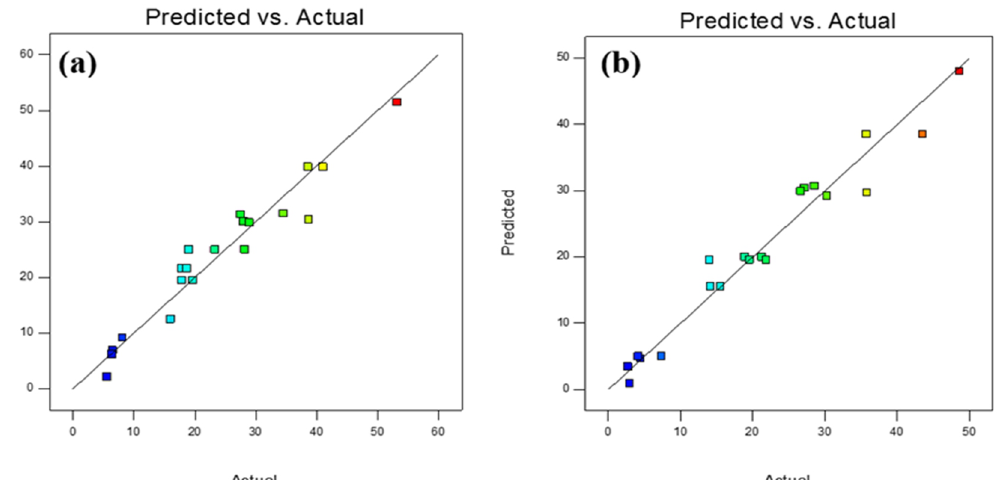
Fig. 3. Comparison of actual and predicted values for a) Cl− ion removal and b) TDS